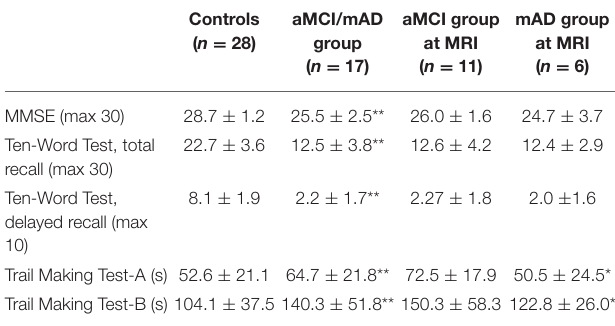
TABLE 1 | Characteristics of the control group and the aMCI/mAD group. Characteristics